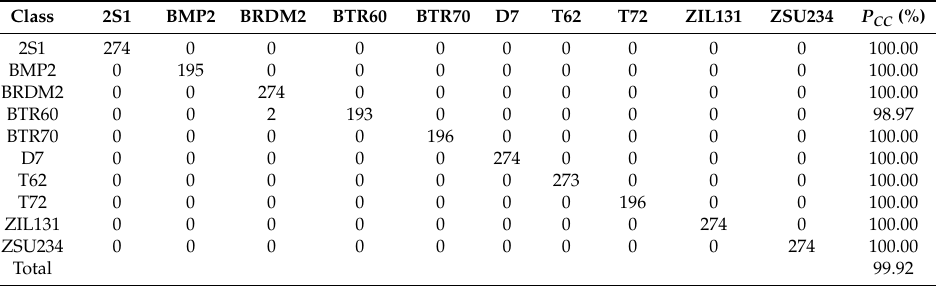
Table 4. Confusion matrix of a four-view MS-CNN under